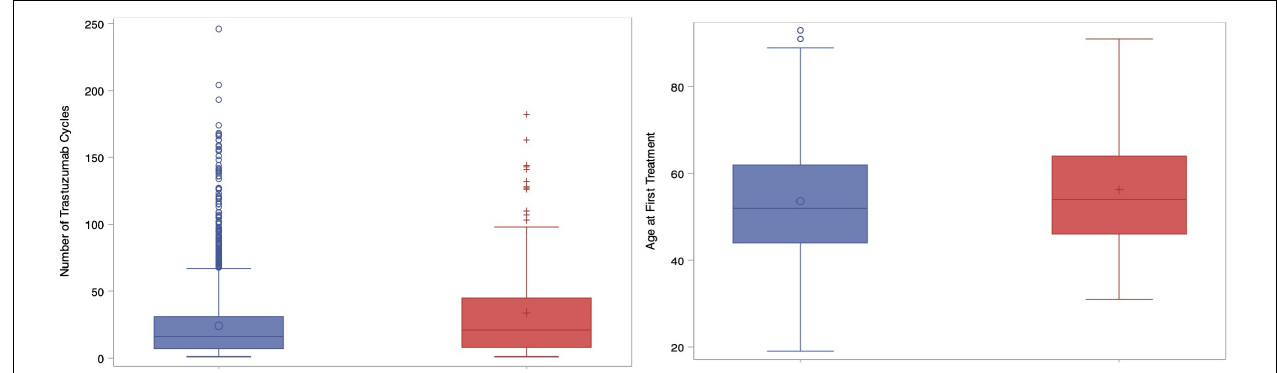
FIGURE 1 | Box plots showing number of trastuzumab cycles (left) and age at first treatment (right) compared between groups. Blue = Group A; Red = Group B.